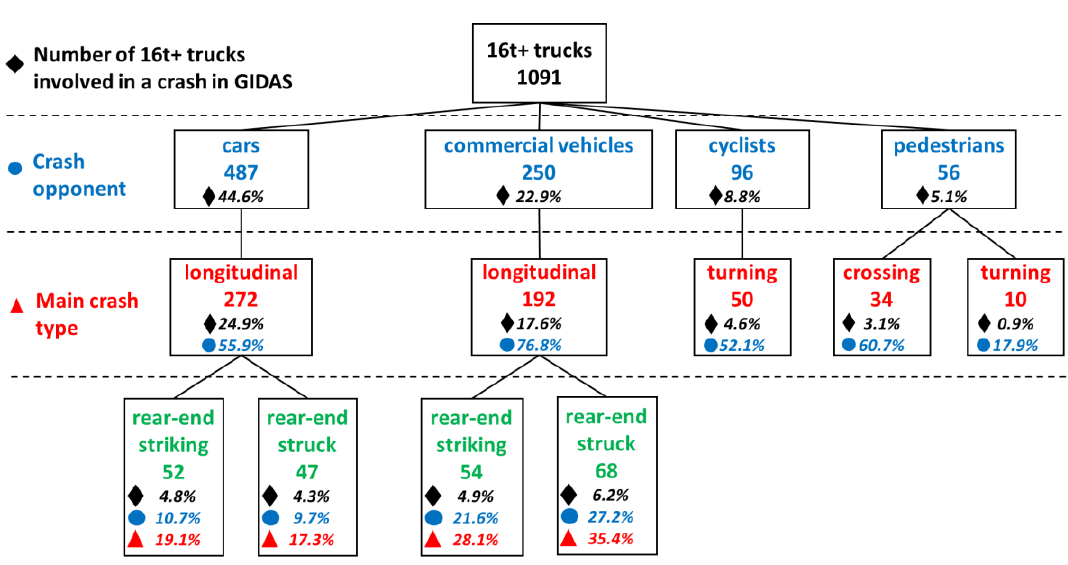
Figure 7 . Most common crash types from GIDAS (case count and percentages per category); less frequent crash types are omitted for readability .